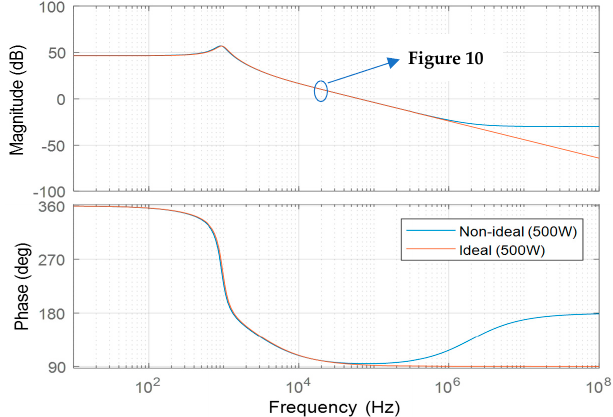
Figure 9. Bode plot showing effects of non-ideal characteristics on the system.